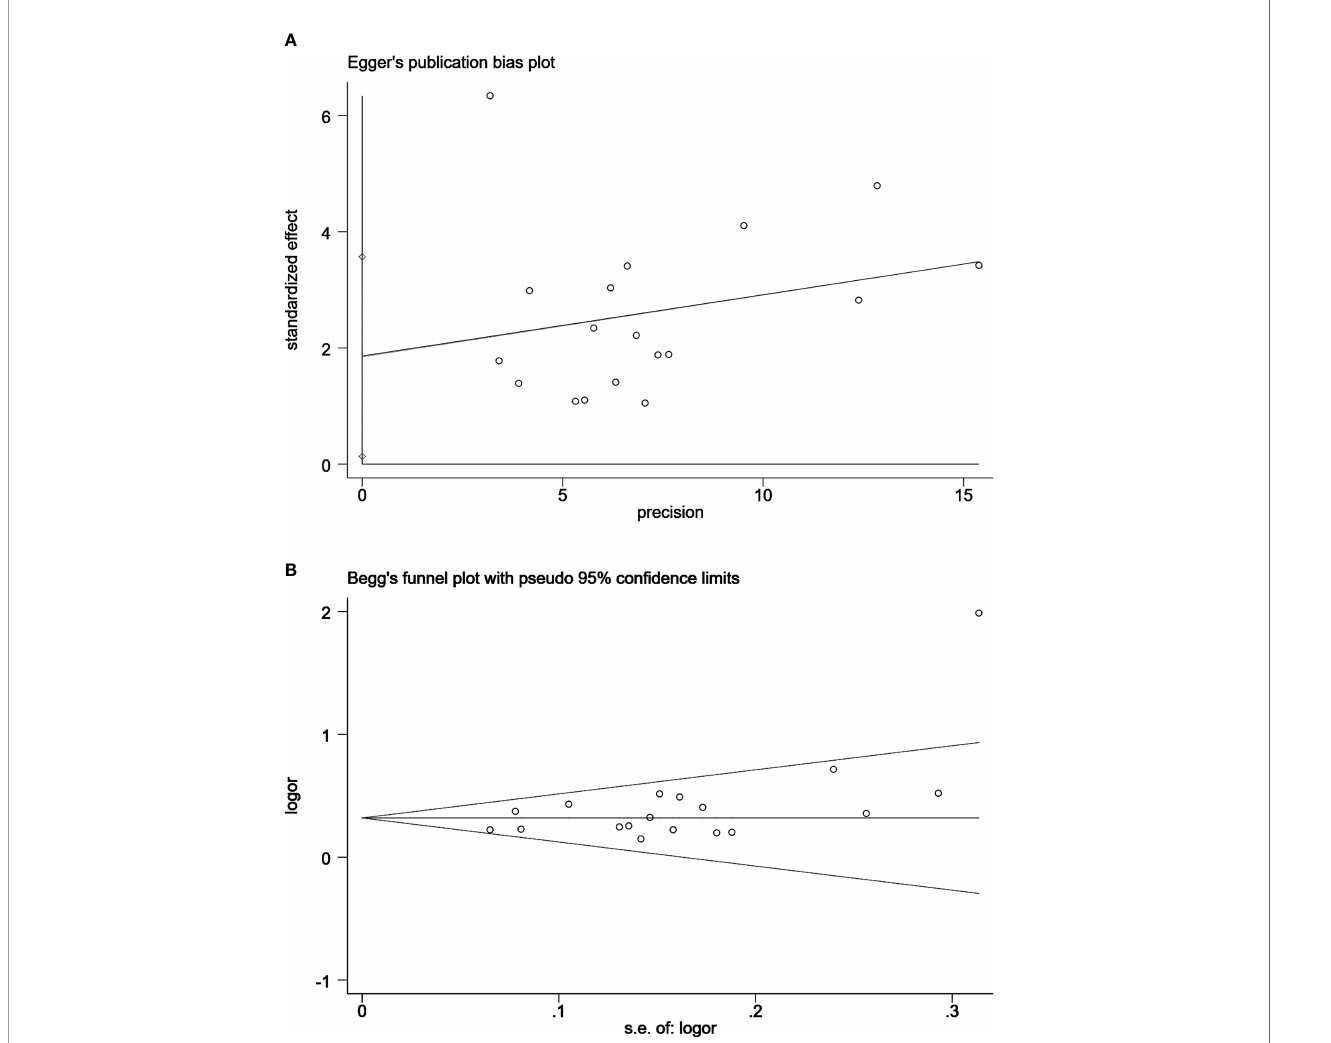
FIGURE 6 | Egger ’ s publication bias plot (A) and Begg ’ s funnel plot (B) for the assessment of publication bias for clinically signi fi cant prostate cancer detection by MRI/Transrectal Ultrasound (TRUS) fusion guided-targeted biopsy (MRI-TB) Combined with systematic biopsy(SB) versus SB. Egger ’ s test, P =0.036. Begg ’ s test, P